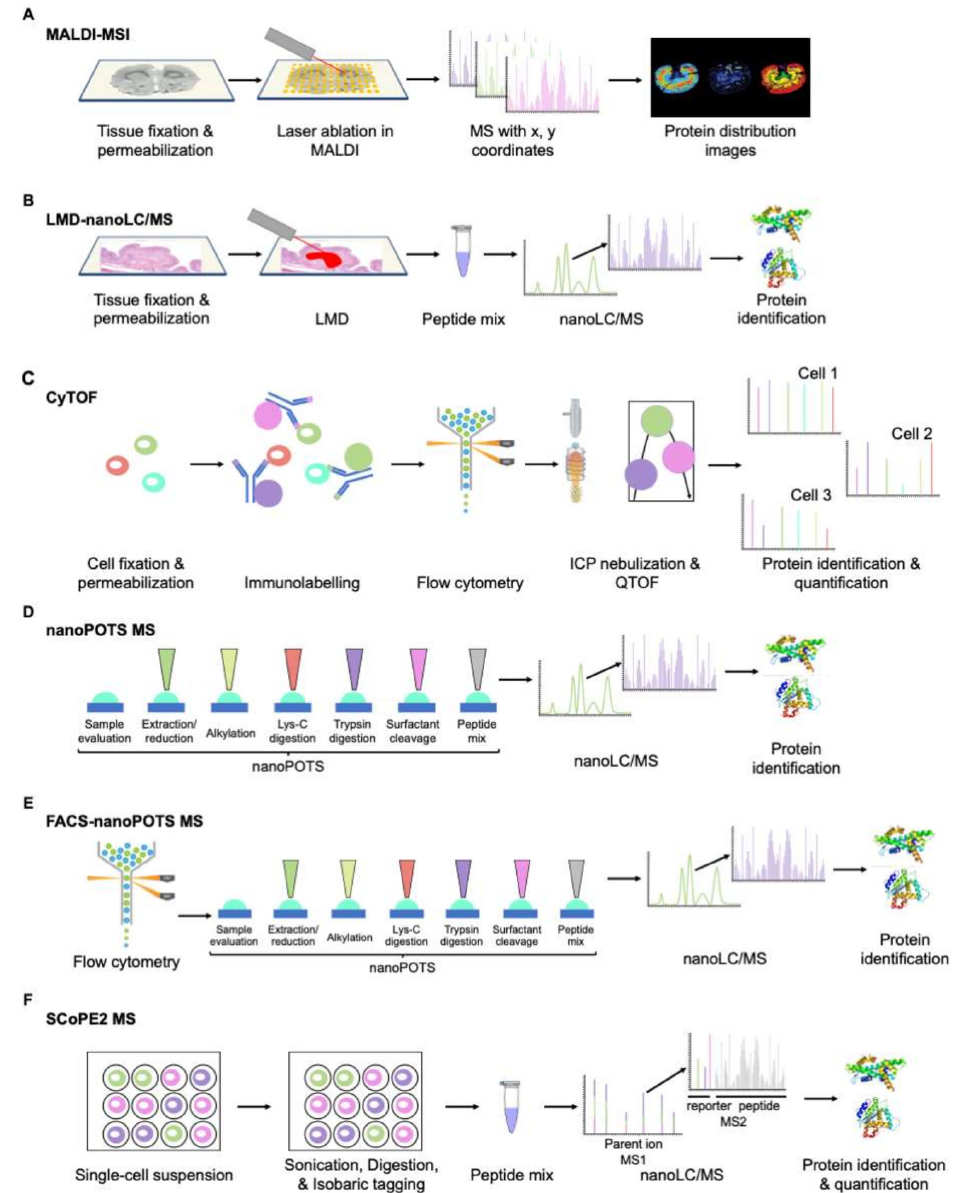
Figure 6. ( A , B ) Hyphenated mass spectrometry techniques orientated to the study of tissues. MALDI- MSI is a shotgun proteomics technique, whereas laser microdissection (LMD) selects a region of interest within the tissue and the laser capture for its subsequent analysis by nanoLC/MS. ( C ) CyTOF (mass cytometry) conjugates the potential of flow cytometry with the multiplexing capacity of mass spectrometry by using a pool of metal-labelled antibodies. Metal signals are analyzed by their time- of-flight and their relative intensity allows for protein quantification from each cell. ( D – F ) nanoPOTS (nanodroplet processing in One-pot for Trace Samples) and SCOPE2 MS (Single Cell ProtEomics by Mass Spectrometry) are microfluidic-based platforms that enable single-cell proteomics analysis and can even be hyphenated to other techniques, such as FACS (fluorescence-activated cell sorting) flow cytometry. With nanoPOTS the protein sample is processed onto individual spots, whereas